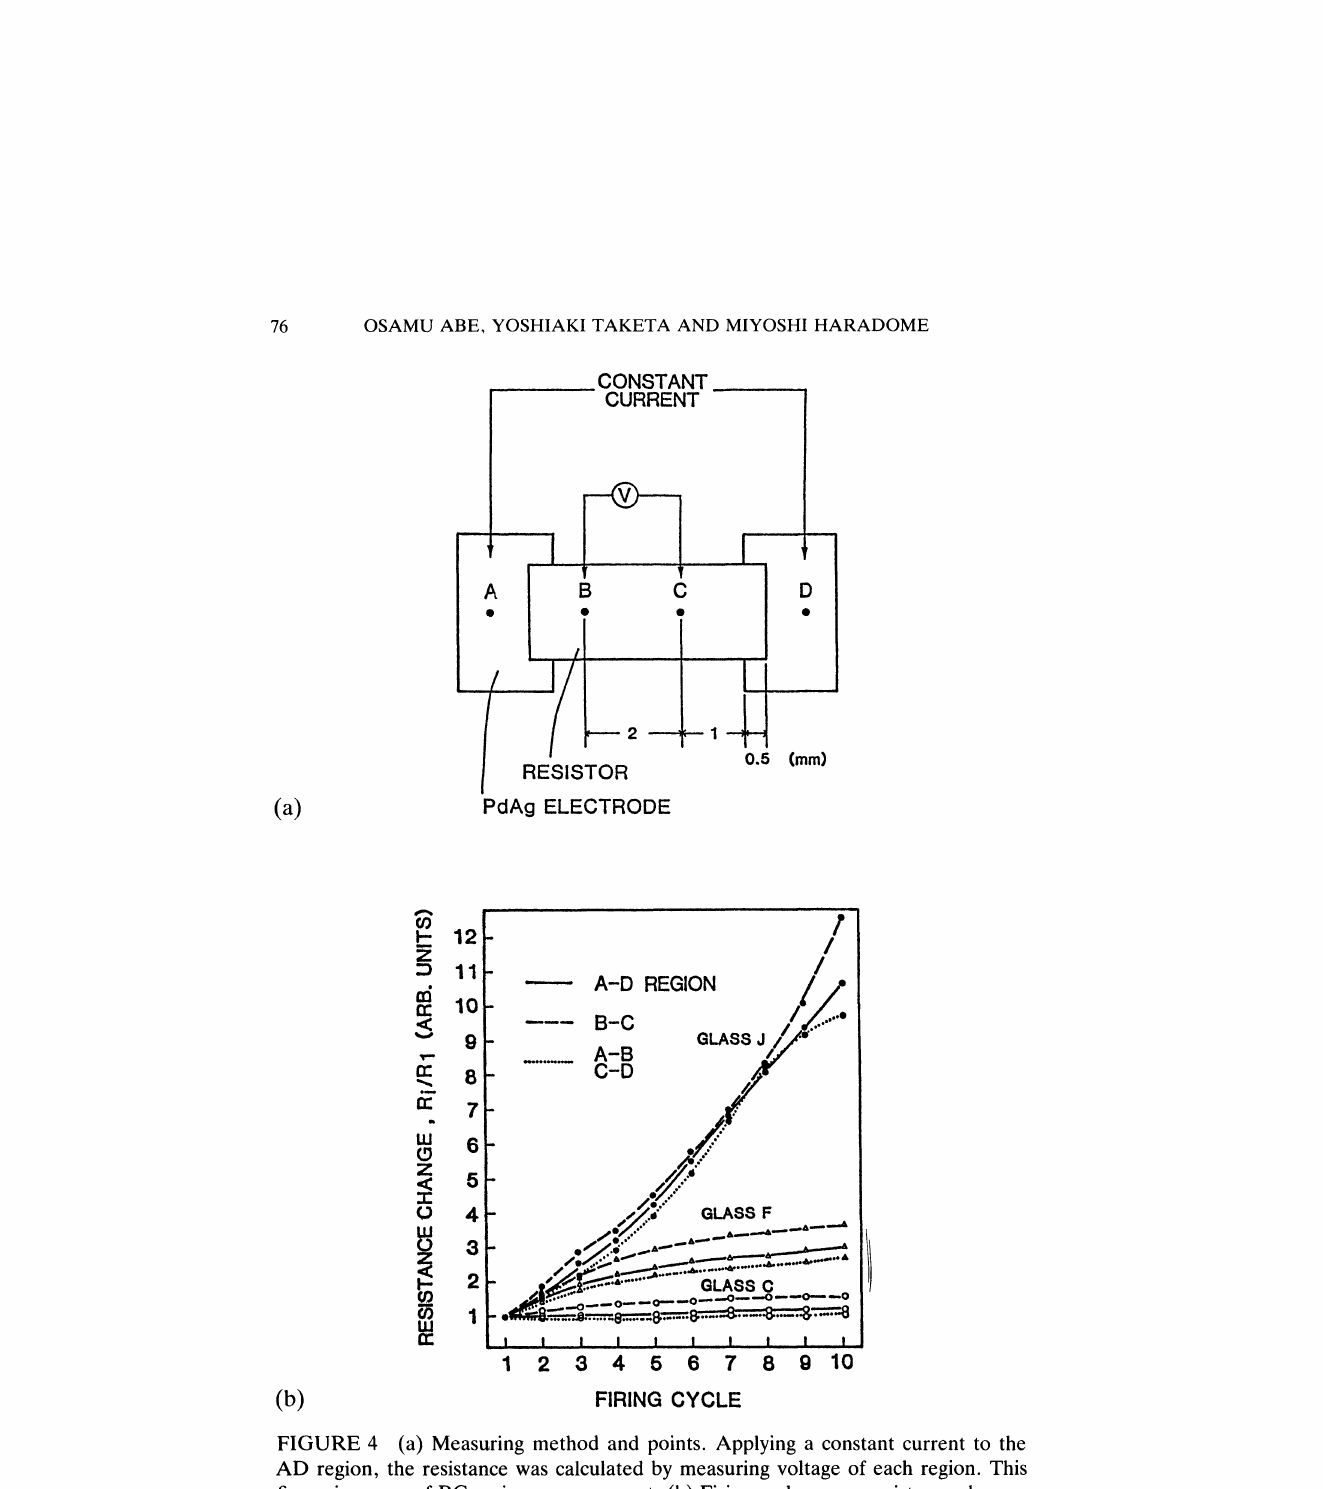
FIGURE 4 (a) Measuring method and points. Applying a constant current to the AD region, the resistance was calculated by measuring voltage of each region. This figure is a case of BC region measurement. (b) Firing cycle versus resistance